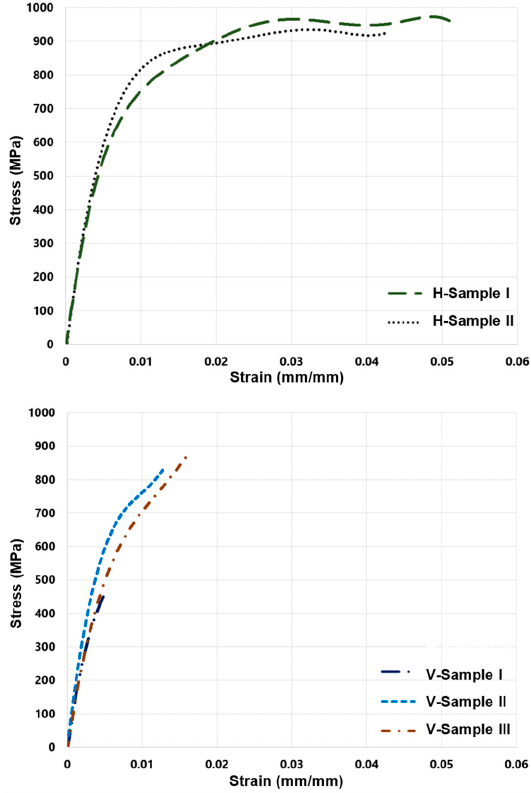
Figure 9. Tensile test results for the H and V test specimens.